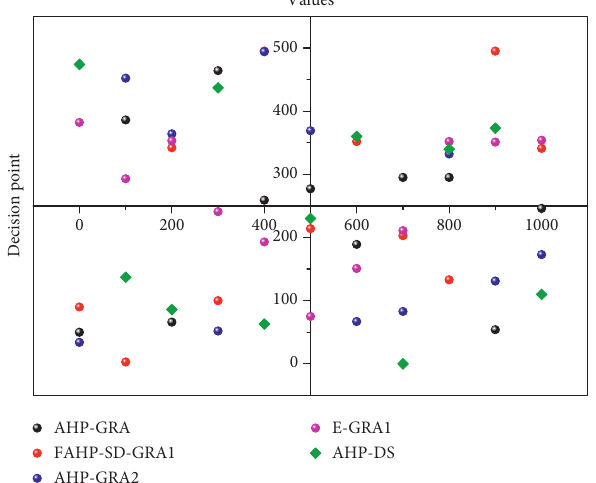
Figure 4: Number of vertical switches for each algorithm under different service